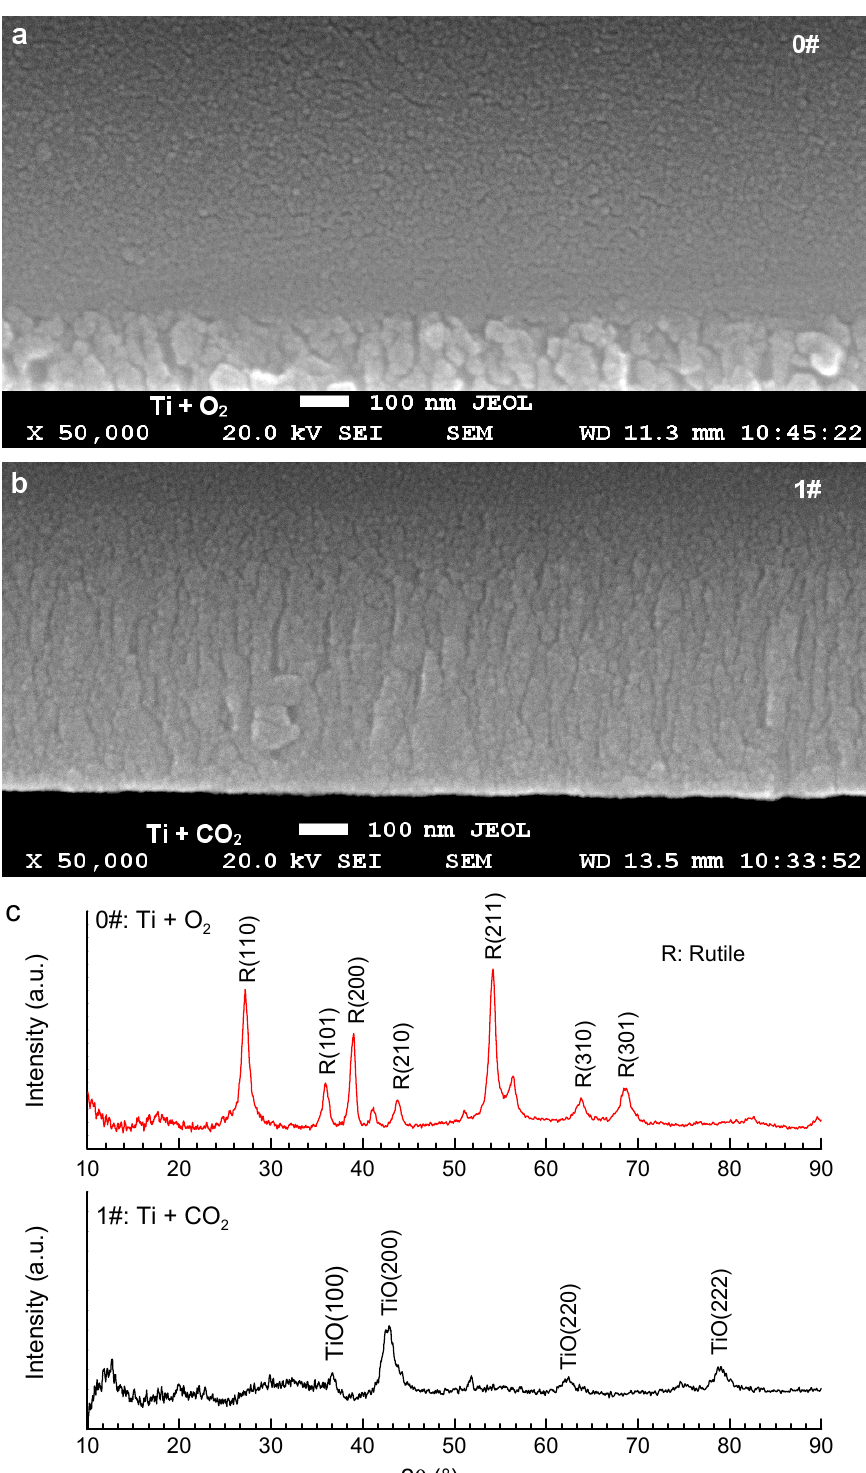
Figure 2. Cross-sectional SEM images of ( a ) sample 0# (Ti + O 2 ) and ( b ) sample 1# (Ti + CO 2 ); ( c ) GI-XRD pattern of the sample 0# and 1#.